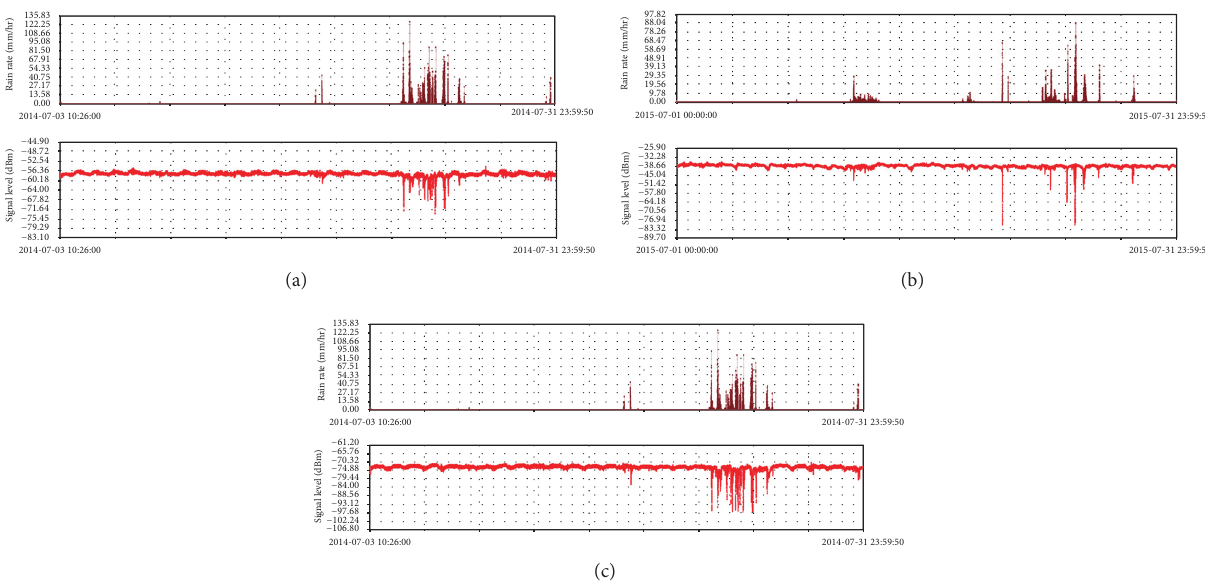
Figure 2: (a) Variation of 12.25 GHz signal level during a rain event [19]. (b) Variation of 20.73 GHz signal level during a rain event [19]. (c) Variation of 19.8 GHz signal level during a rain event [19].